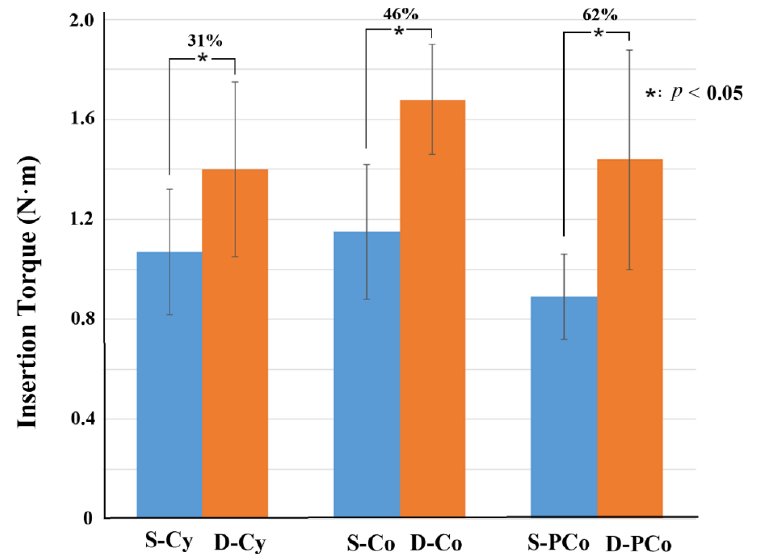
Figure 4. Mean maximal insertion torque for screws of various geometries. The insertion torques of screws in the S-Cy, S-Co, S-PCo, D-Cy, D-Co, and D-PCo groups were 1.07 ± 0.25, 1.15 ± 0.27, 1.0 ± 0.17, 1.4 ± 0.35, 1.68 ± 0.22, and 1.44 ± 0.44 Nm, respectively. For screws with the same shape, the